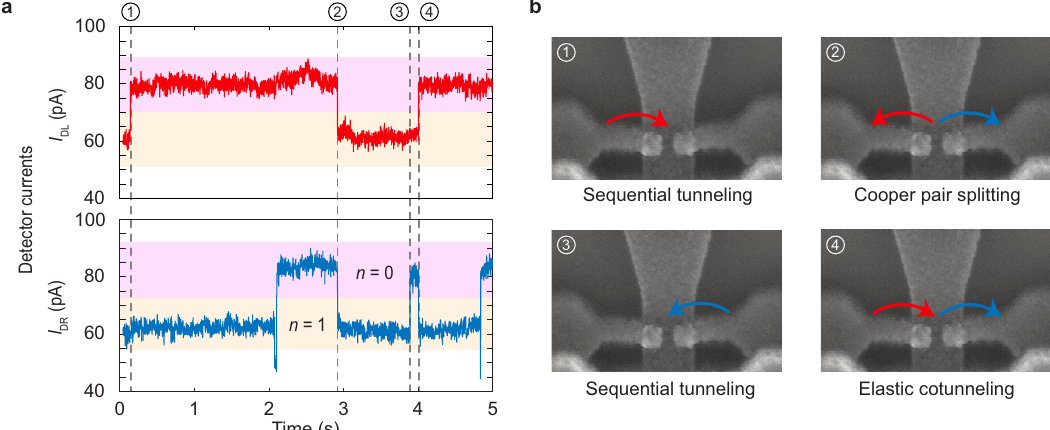
Fig. 2 Real-time observation of Cooper pair splitting. a Typical time traces of the currents I DL and I DR in the left and the right single-electron transistors correspondingly, which switch between two distinct levels corresponding to having n = 0 or 1 (excess) electrons on each island. b The points marked with ① and ③ in the left panel correspond to processes, where a single electron tunnels between the superconductor and one of the islands. The point marked with ② is a Cooper pair splitting event, where two electrons simultaneously tunnel from the superconductor into the two islands, one in each, while the point marked with ④ is an elastic cotunneling event, where an electron is transferred between the two islands via the